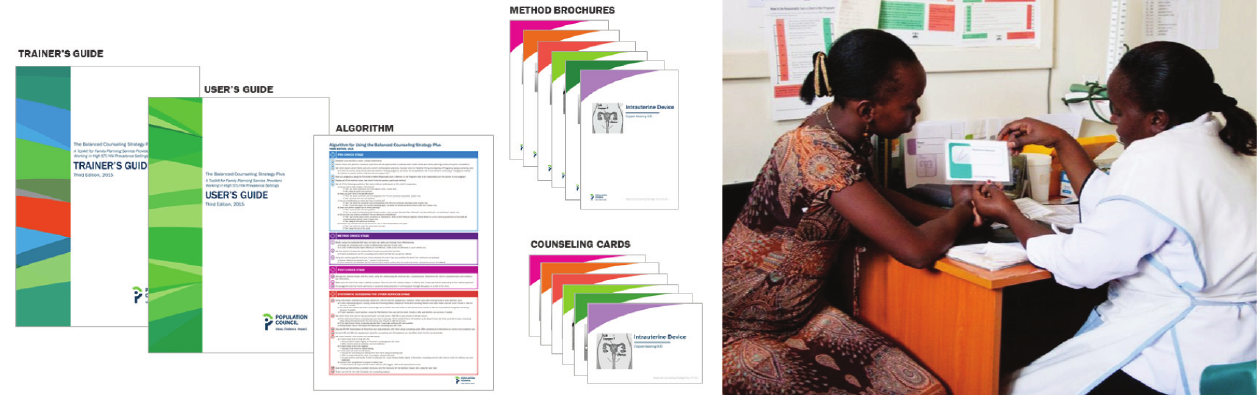
Figure 1. Balanced Counseling Strategy Plus (BCS+) toolkit (Third edition). Consent for publication of the image was obtained from the individuals in the